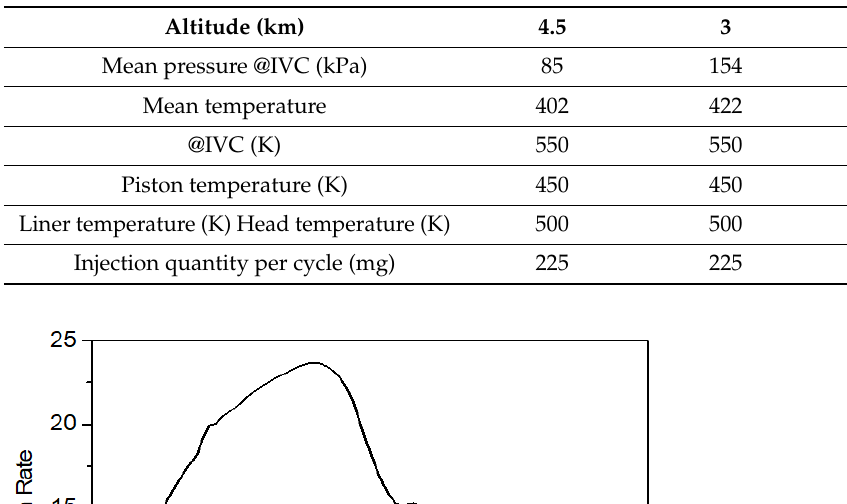
Table 2. Initial and boundary conditions of simulation.